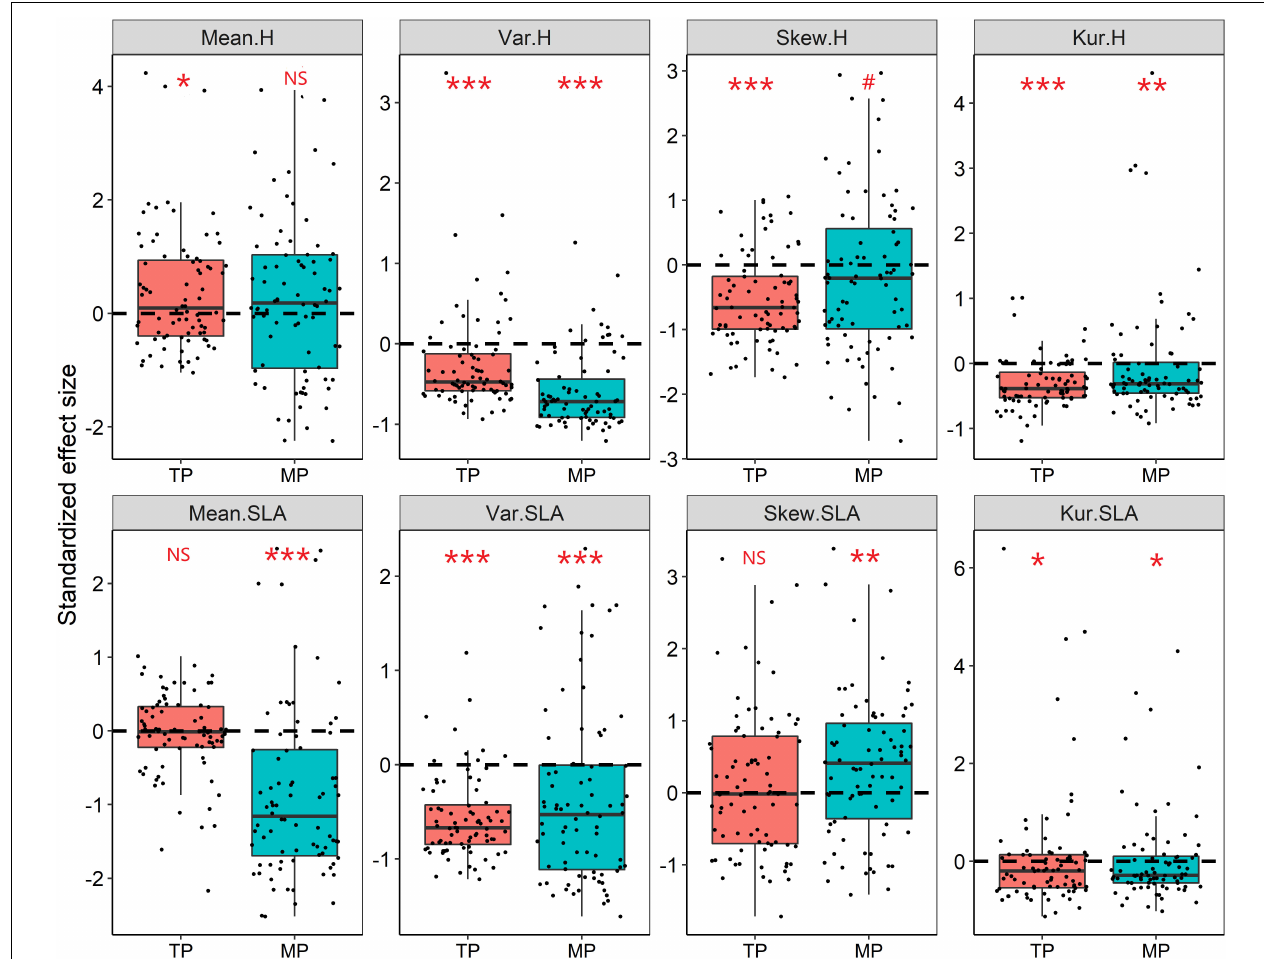
FIGURE 4 | Standardized effect size (SES) values for the mean, variance, skewness, and kurtosis of the height and SLA distributions within grassland communities. The Wilcoxon test was conducted to test significant deviations within each observed trait metric from the null expectation (SES = 0), NS, P > 0.05; # P < 0.1; * P < 0.05; ** P < 0.01; *** P < 0.001. The black dashed line indicates the value of